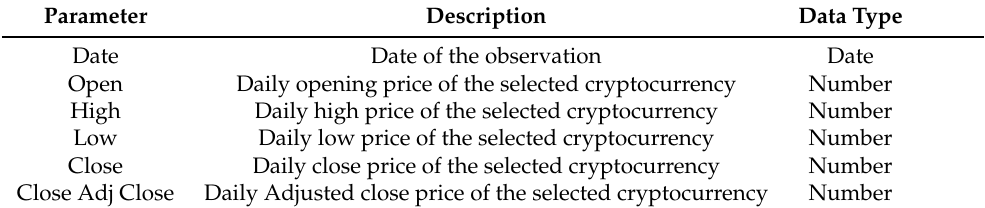
Table 1. Dataset